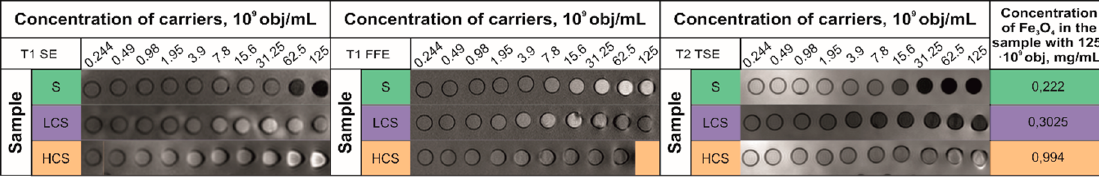
Figure 6. MRI images of magnetic submicron core–shells.